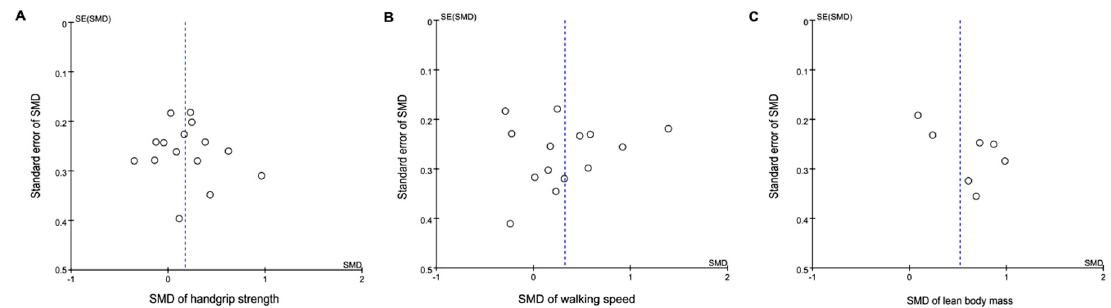
Figure 4. Funnel plots of the intervention effects for ( A ) handgrip strength, ( B ) walking speed, and ( C ) lean body mass. Each circle represents an independent comparison, with the x -axis representing standard mean difference (SMD) over control comparisons and the y-axis showing the standard error (SE) of SMD. The vertical dotted line indicates the mean value of the SMDs.